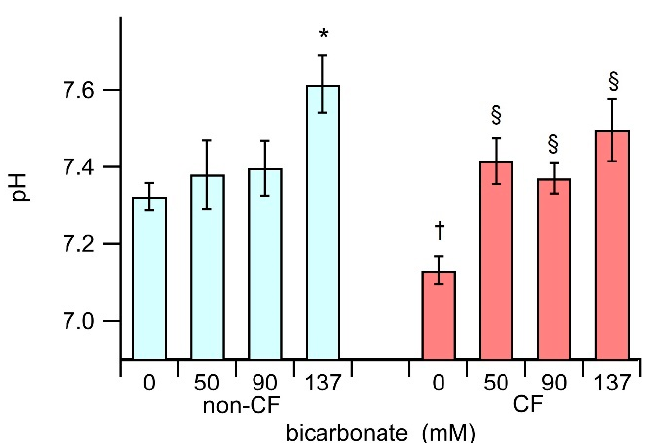
Figure 2. pH of the apical fluid recovered from the HBEC-monolayers, cultured on Snapwell permeable supports, from three different non-CF (cyan), and three different CF (red) subjects, treated with iso-osmotic solutions with different concentrations of bicarbonate. The asterisk (*) indicates that data is statistically different ( p < 0.03) from the non-CF incubated in 0 bicarbonate solution; the section sign (§) indicates that data is statistically different ( p < 0.0006) from the CF in 0 bicarbonate, and the dagger (†) indicates that untreated CF is statistically different ( p < 0.0005) from the non-CF in 0 bicarbonate.